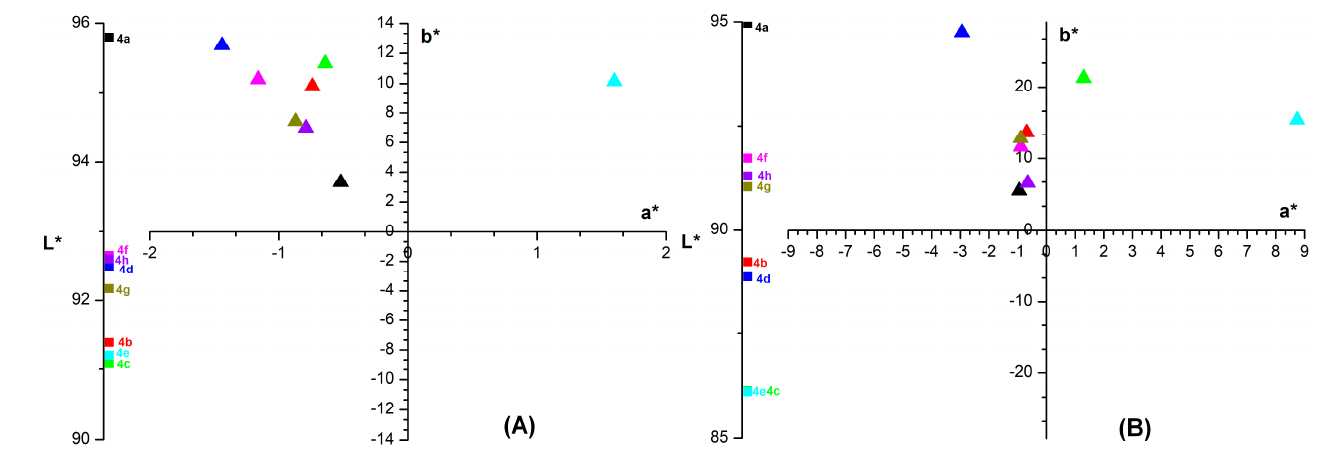
Figure 7. The extreme color parameters in the CIEL*a*b* system for all the new synthesized dyes at 2% ( A ) and 15% ( B ).